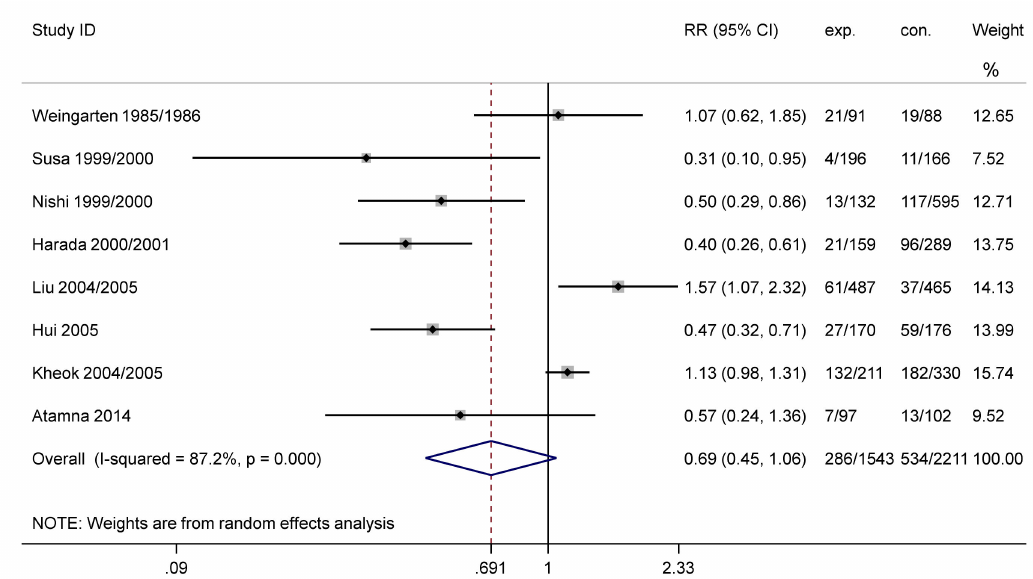
Figure 4. Forest plot of ILI incidence. ILI, influenza-like illness; ID, identification; exp., experimental group; con., control group; RR, risk